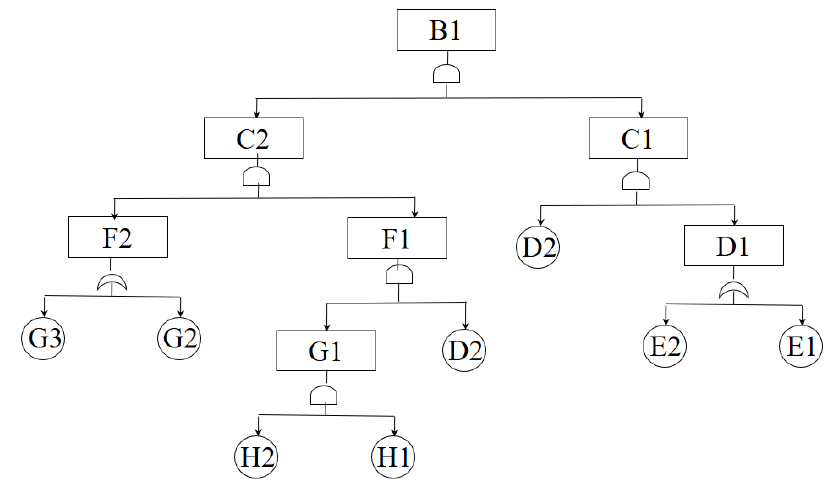
Figure 6. Fault tree of ship collisions with wind turbines.